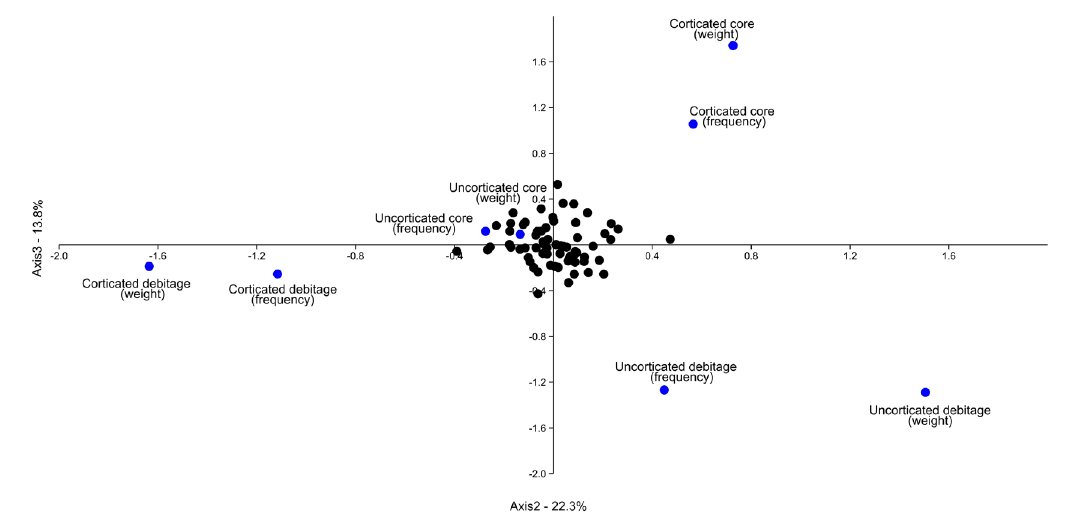
Figure 4: Correspondence analysis of Type 1 limnosilicite and the plot according to the second and third axis.